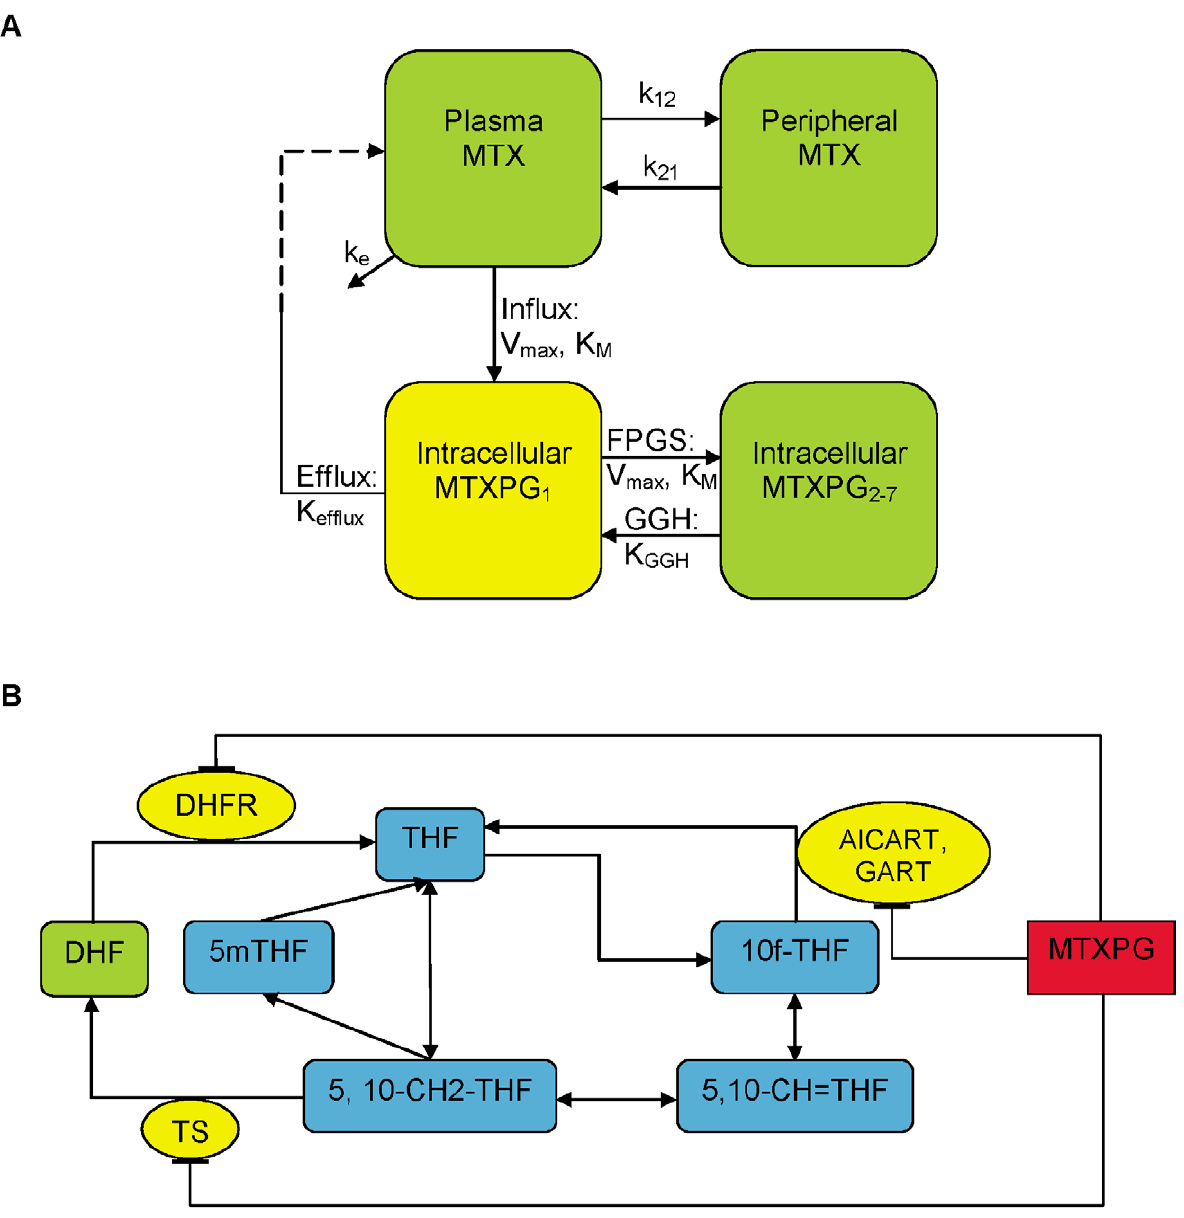
Figure 8. Model schematic. ( A ) The pharmacokinetic model for plasma and intracellular MTX and MTXPG [9]. The parameters are defined in the text. The dashed line describing the efflux of intracellular MTX back to the plasma represents the fact that the system is uncoupled, i.e. we account for the efflux of intracellular MTX but we do not explicitly account for its return to the plasma. ( B ) The folate pathway model [12] is modified to include the pathways inhibited by MTXPG. The model parameters (described by arrows) are defined in the text and supplemental